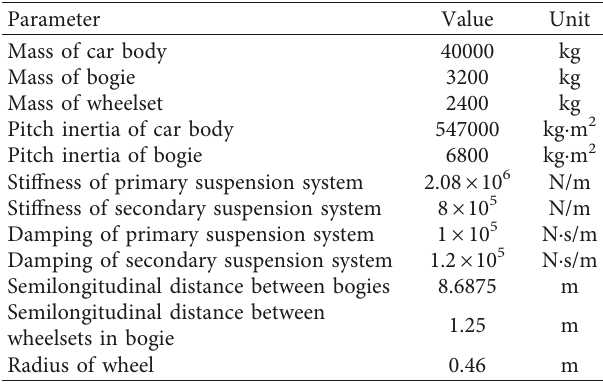
Figure 1: The vehicle-track system model of high-speed railway. Table 1: Parameters for Chinese high-speed train CRH3 [13].